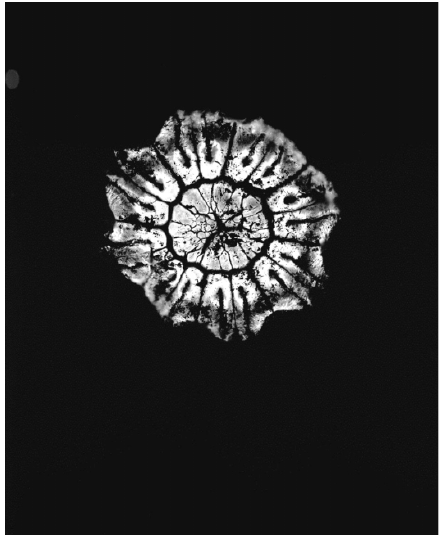
Fig. 5. Susanne Ramsenthaler. From the series Bloom . Photogram on silver gelatine